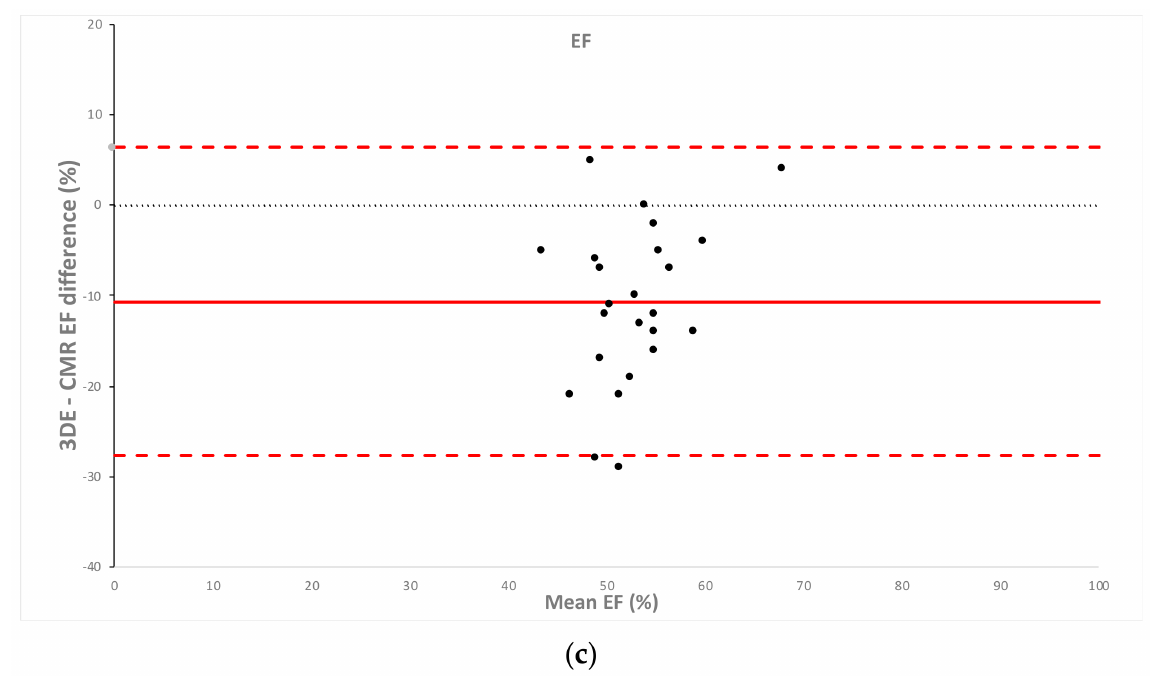
Figure 2. Bland–Altman analysis of bias (red solid line) and 95% limits of agreement (red dashed line) for multi-beat 3DE versus CMR quantification of ( a ) RV EDV, ( b ) RV ESV and ( c ) RV EF in patients. 3DE: three-dimensional echocardiography. CMR: cardiac magnetic resonance. RV EDV: right ventricular end-diastolic volume. RV ESV: right ventricular end-systolic volume. RV EF: right ventricular ejection fraction. LOA: limits of agreement. ICC: intraclass